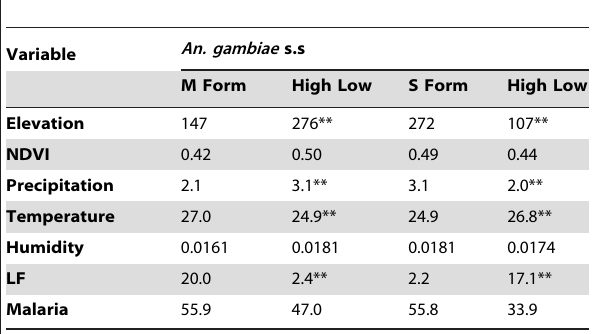
Table 3. Comparison of mean environmental and epidemiological measures between high and low prevalence areas of An. gambiae s.s molecular